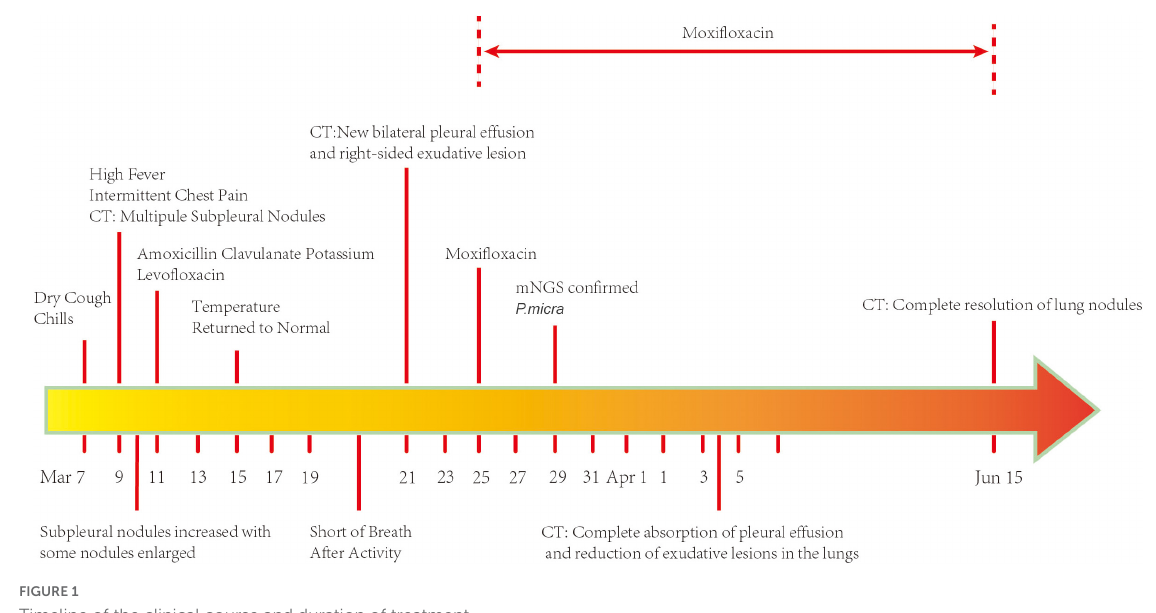
FIGURE1 Timeline of the clinical course and duration of treatment.